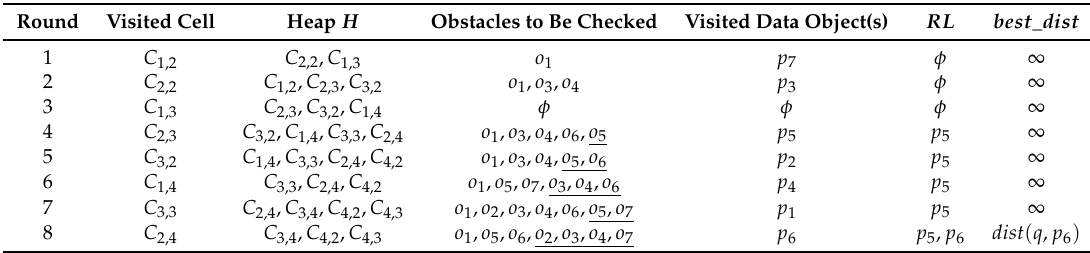
Table 3. The example steps of the baseline algorithm when calling the Visibility Check Ver. 2 (VC2) algorithm for visibility checking. Note that the “underlined” obstacles are checked in the VC algorithm but are not verified in the VC2 algorithm.